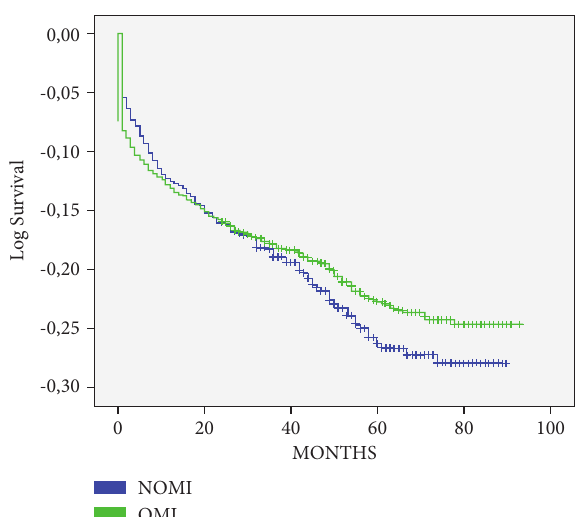
Figure 2: All-cause mortality during follow-up period. NOMI, nonocclusive myocardial infarction; OMI, occlusive myocardial